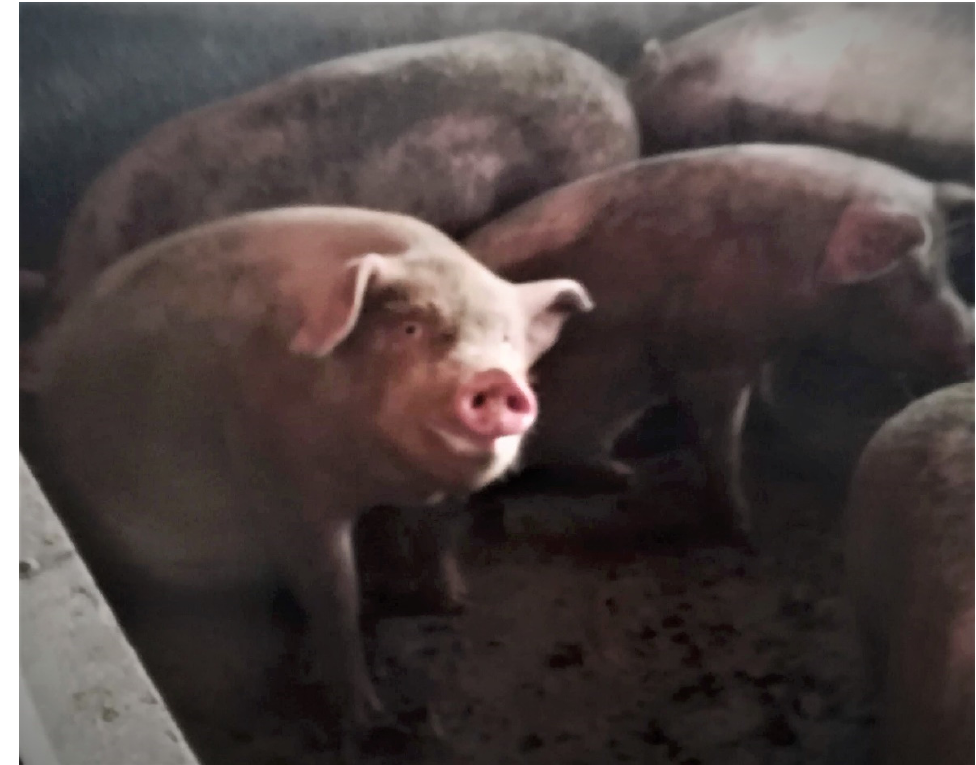
Figure 4. Example of dog sitting stereotypic behavior frequently observed during the behavioral